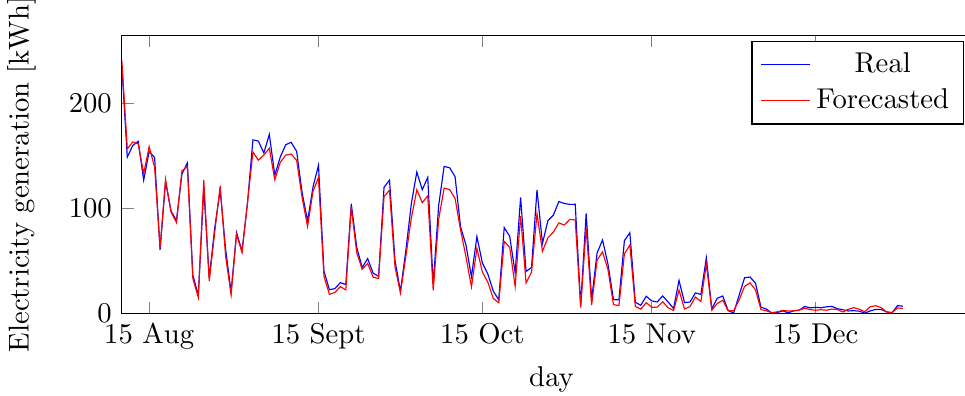
Figure 11. Forecasting results for 10 August to 31 December 2021 using SVR.